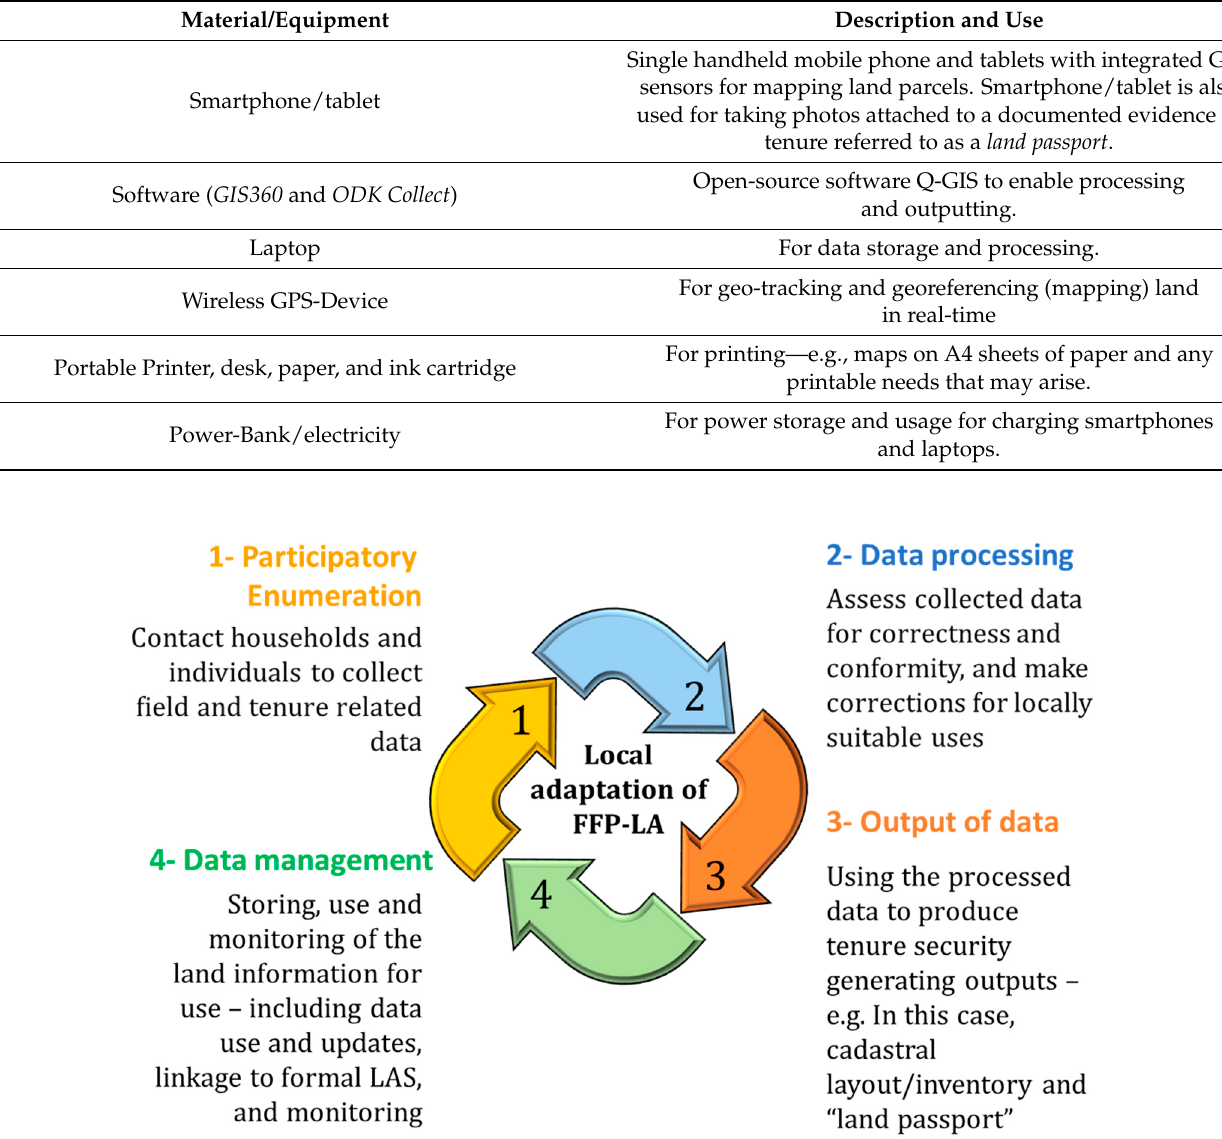
Table 1. Equipment and materials for the youth-led land survey/inventory Juaben-Atia (Source: Authors’—based on materials for land use inventory exercise).